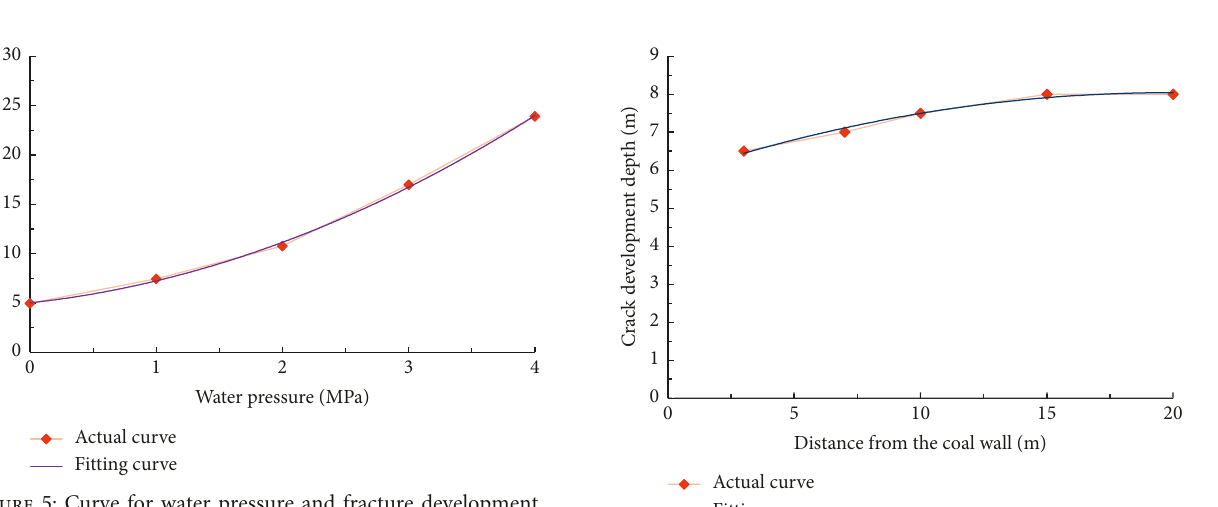
Figure 4: Fitting curves of fracture development depth versus (a) internal friction angle and (b) cohesion.